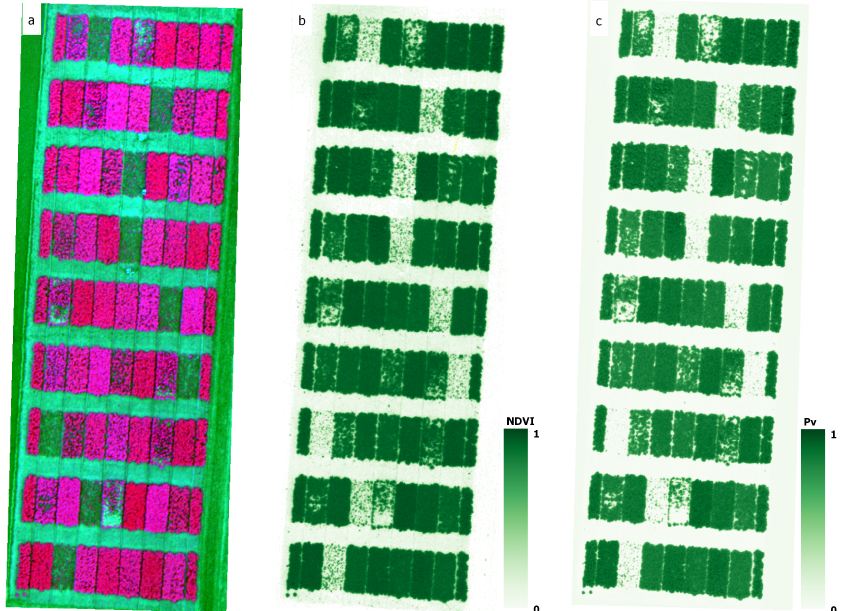
Figure 5. Rapeseed experiment with 63 plots of 3 × 6 meters planted with 10 different genotypes with a minimal repetition of 6 plots. Differences between the varieties are highlighted by the CIR map ( a ); the NDVI ( b ) and P v ( c ) maps were used to estimate the emissivity (11 April 2018, 13:42